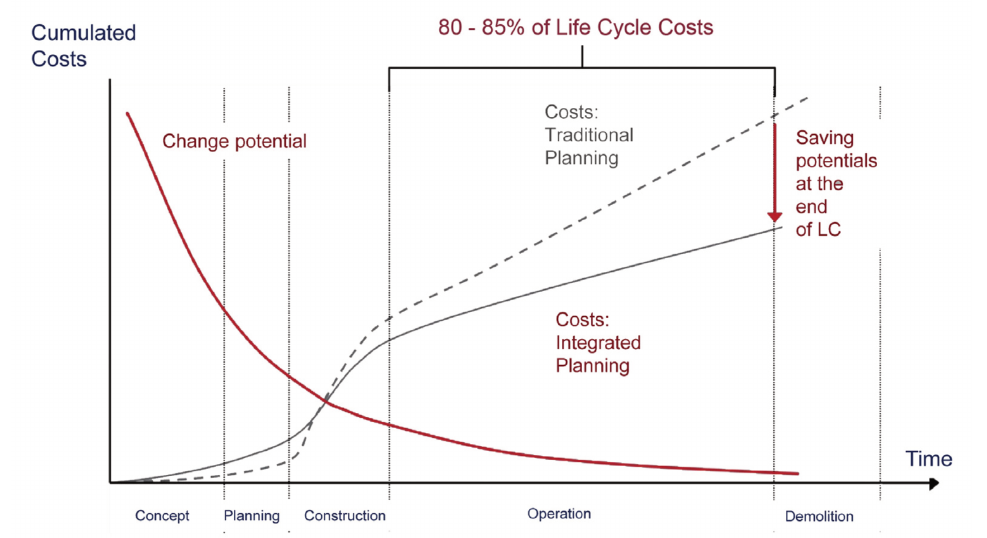
Figure 2. Cost development vs. change potential over building life cycle